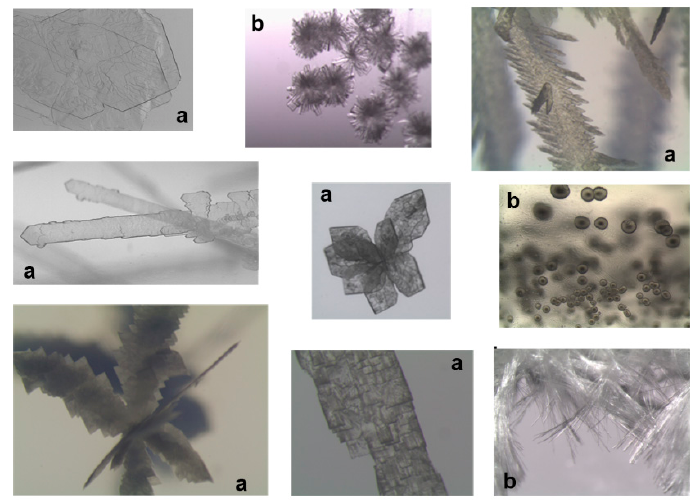
Figure 5. Different morphologies observed for the crystals of 1D- cha ( a ) and 3D- sra ( b ) species.